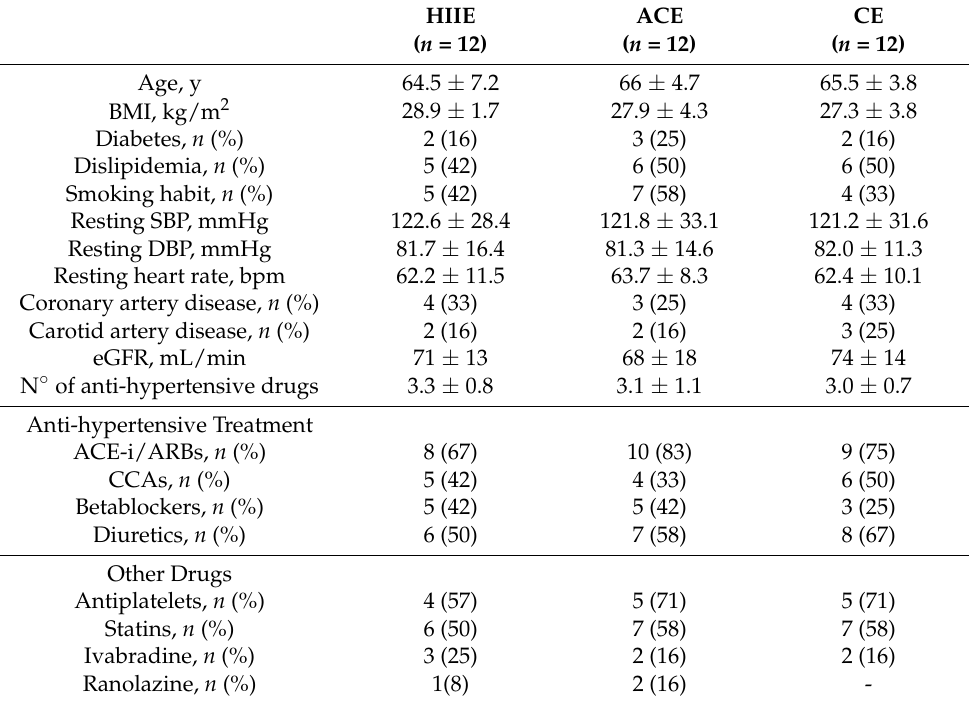
Table 1. Baseline characteristics of patients.